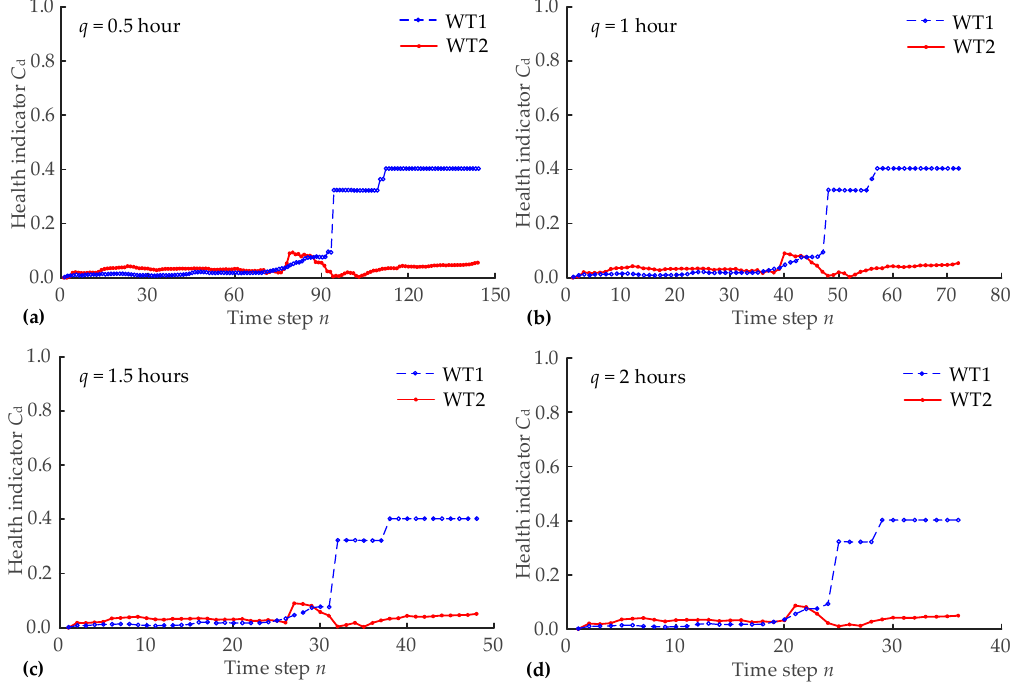
Figure 10. Effect of time increment on the health indicators of the wind turbine: ( a ) q = 0.5 h, total time step n = 145; ( b ) q = 1 h, total time step n = 73; ( c ) q = 1.5 h, total time step n = 49; ( d ) q = 2 h, total time step n = 37.